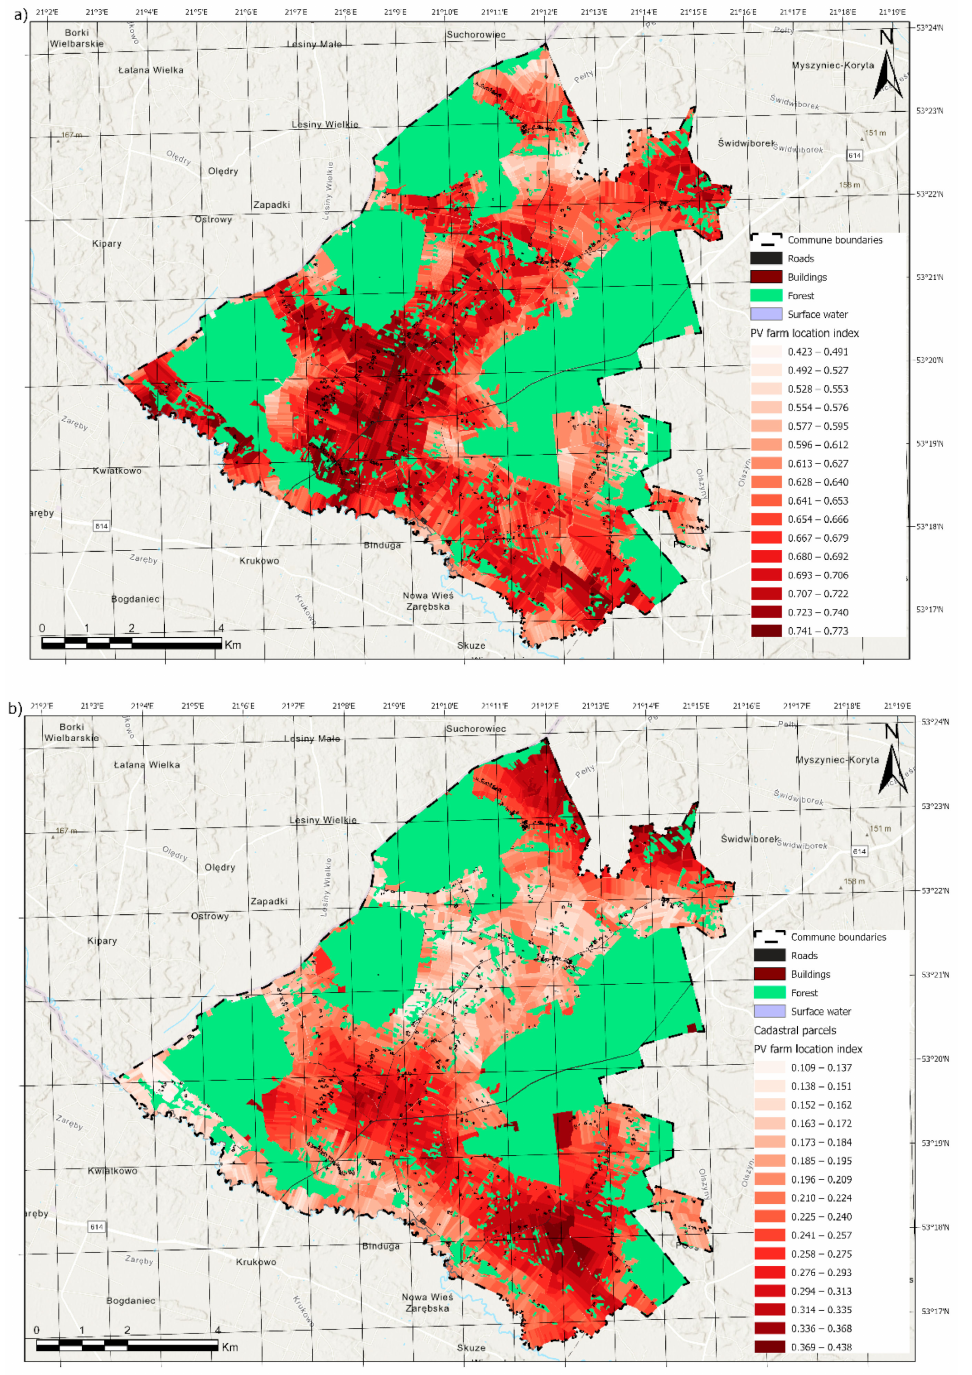
Figure 13. A comparison of the values of the optimum PV farm location index using: ( a ) the AHP method, and ( b )